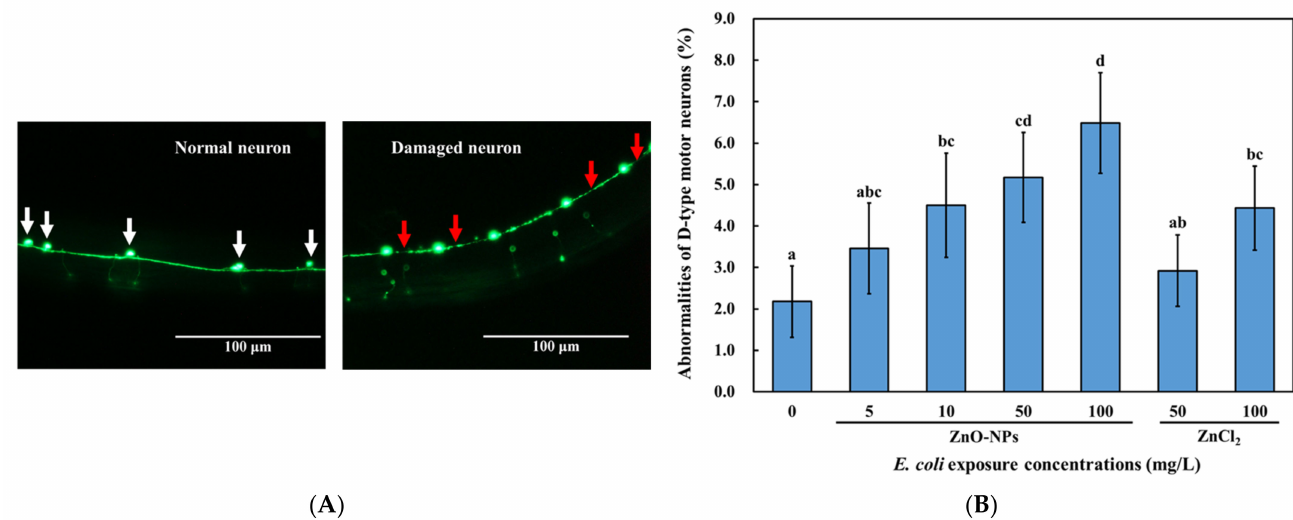
Figure 5. GABAergic neuron damage resulted from dietary transfer of ZnO-NPs in C. elegans. Transgenic strain EG1285 ( unc-47 p::GFP) L1-larvae were fed with ZnO-NPs or ZnCl 2 pretreated E. coli OP50 for 72 h. After exposure and washing, fluorescence images of worms were taken to determine neural abnormalities, including neuron loss and degenerating commissures of GABAergic D-type motor neurons. ( A ) Representative image for determination of GABAergic neuronal damage. White arrows indicate normal cell bodies; red arrows indicate gaps on the neuronal cord. ( B ) GABAergic neuron damage resulted from dietary transfer of ZnO-NPs. The data are shown as the mean ± SEM. The tests were conducted at least three times independently, and 20 worms were scored per treatment in each replicate. Statistical significance was determined by one-way ANOVA with LSD post-hoc test and indicated by different lowercase letters ( p <